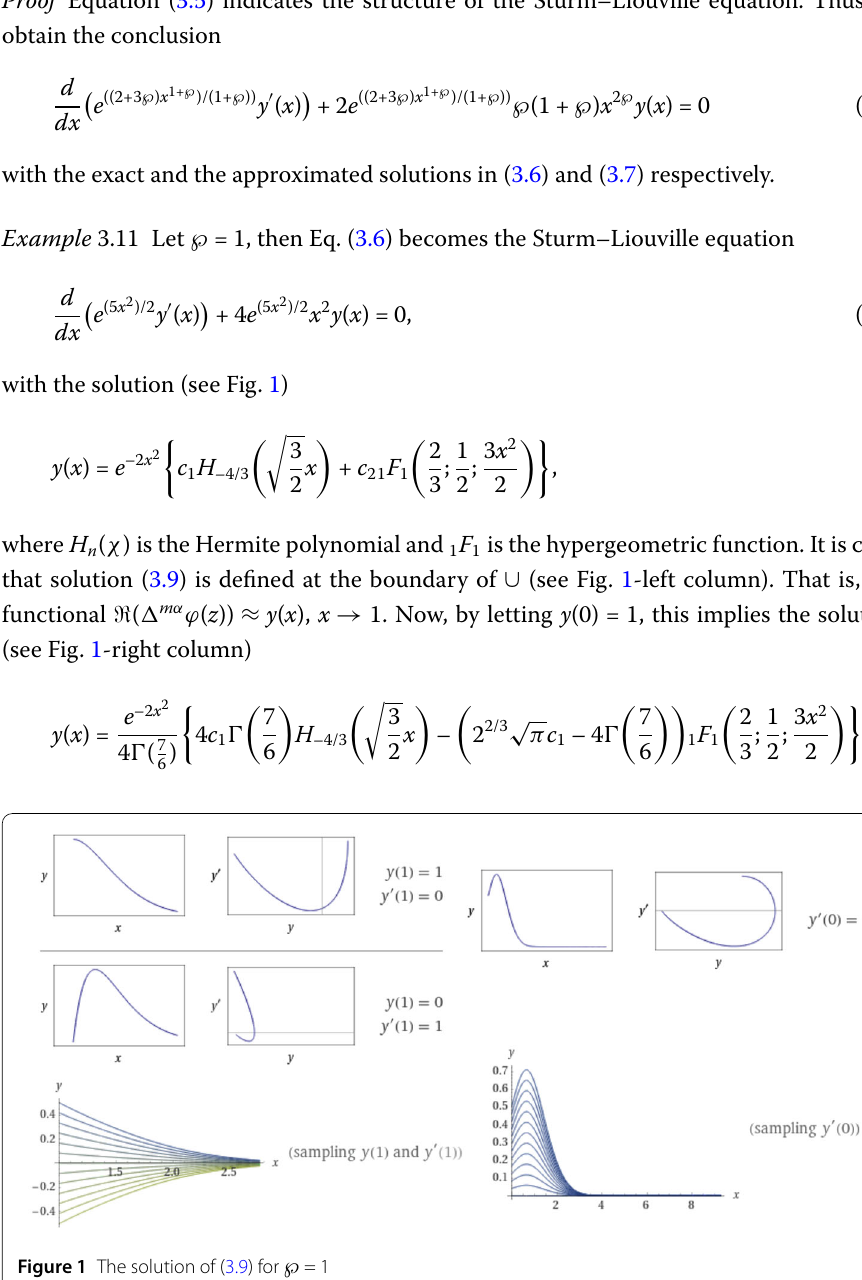
Figure 1 The solution of (3.9) for ℘ =